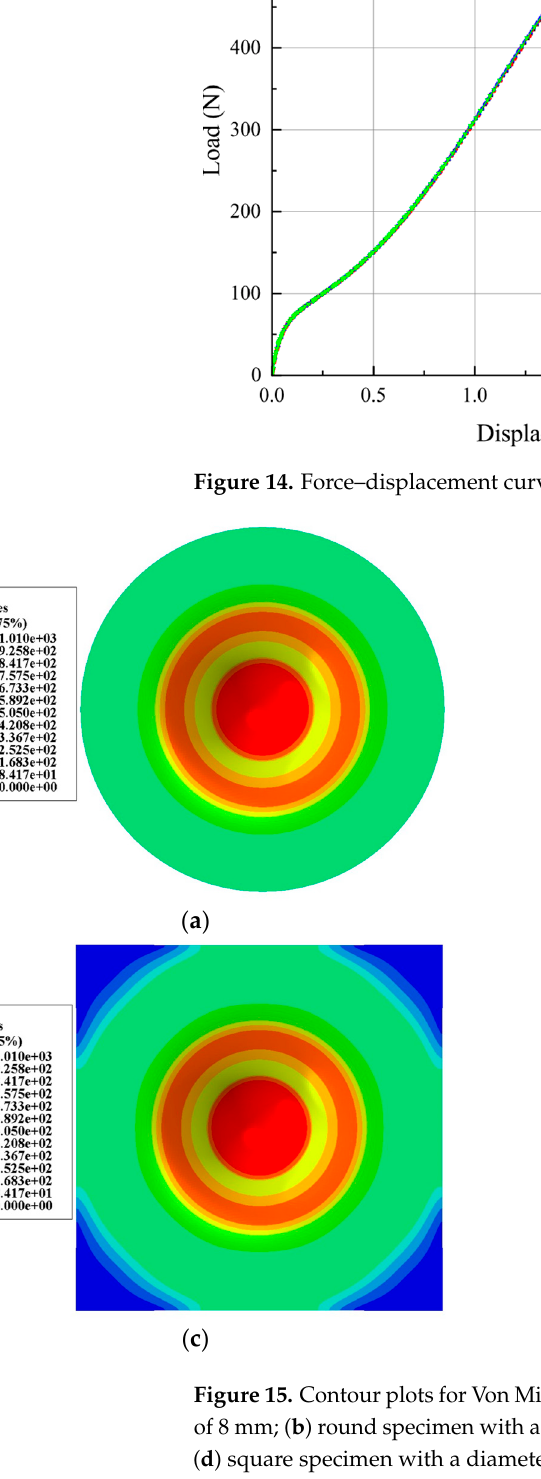
Figure 15. Contour plots for Von Mises stress on FE model of SPT. ( a ) round specimen with a diam- eter of 8 mm; ( b ) round specimen with a diameter of 10 mm; ( c ) square specimen with a diameter of 8 mm; ( d ) square specimen with a diameter of 10 mm.